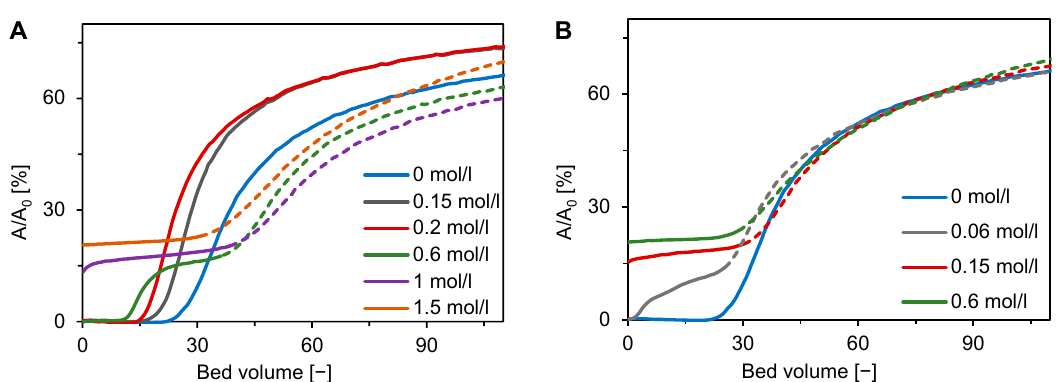
Figure 9. Influence of salt type and ionic strength on two-component adsorption of BSA and DNA on Sartobind STIC using a micromembrane module with pump-forced flow at pH 8. ( A ) NaCl and ( B ) Na 2 SO 4 . Breakthrough curves for different ionic strengths, expressed via relative absorbance, are distinguished by different colors. The solid and dashed lines correspond to the first and second adsorption fronts in the breakthrough, respectively.